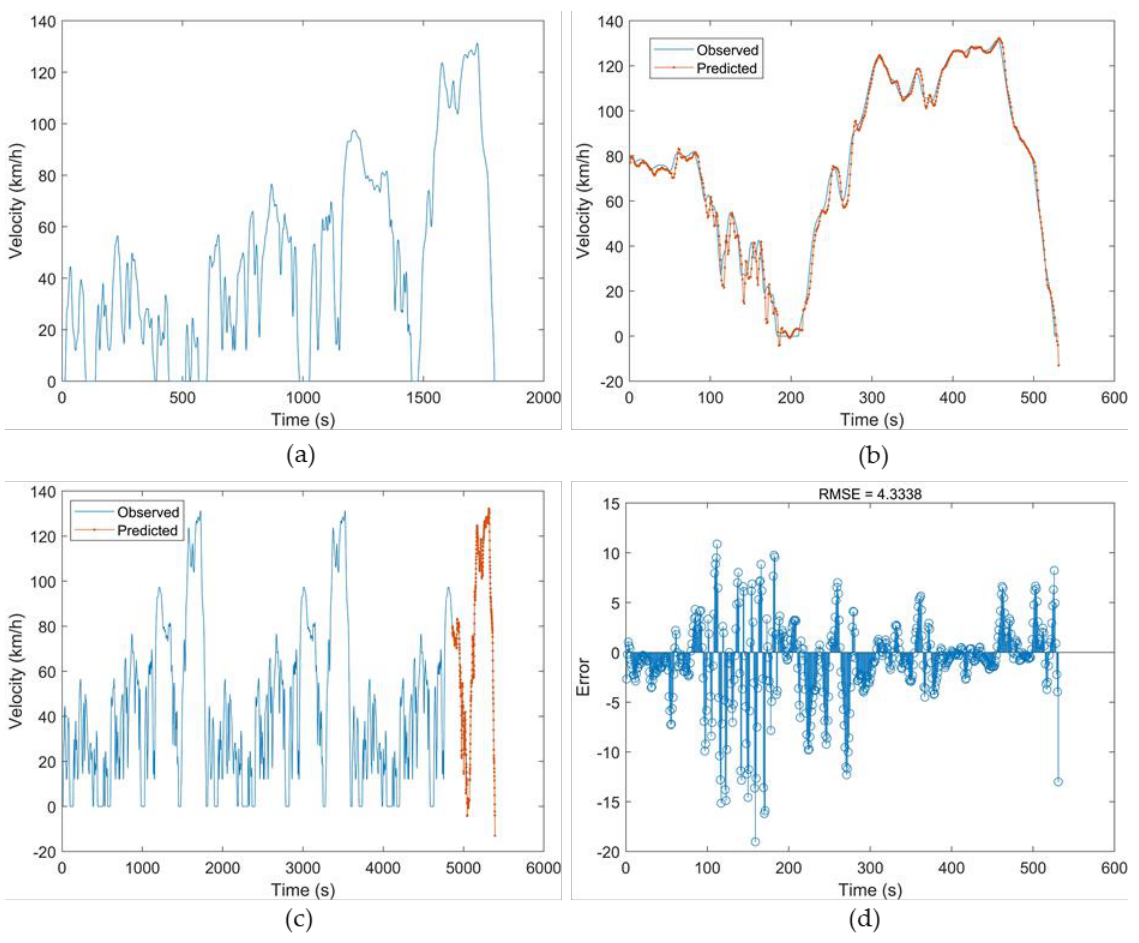
Figure 7. Speed prediction based on neural network model: ( a ) vehicle speed sample; ( b ) prediction sequence in test set; ( c ) GRU based vehicle velocity prediction results; ( d ) prediction error.